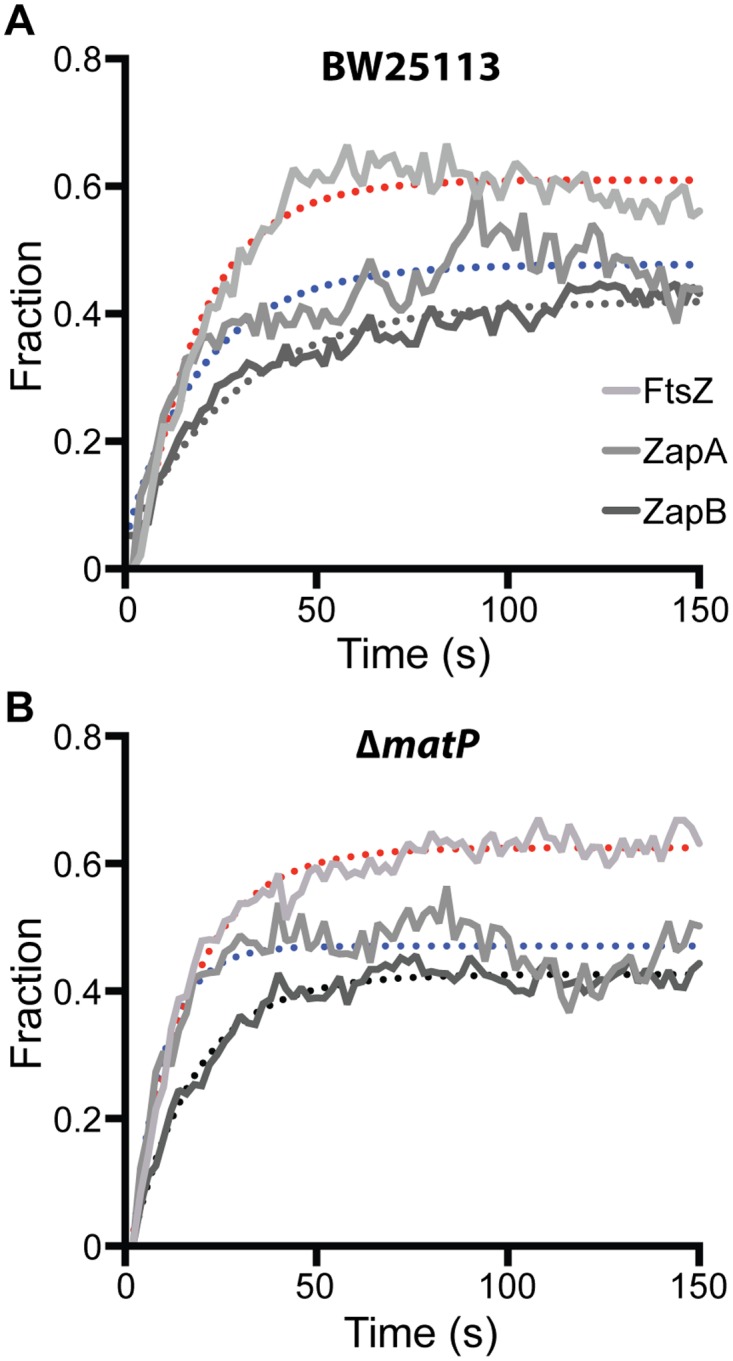
FRAP measurements of FtsZ, ZapA and ZapB turnover rates in BW25113 and ΔmatP cells.Average fluorescence recovery trajectories for FtsZ (light grey), ZapA (grey) and ZapB (dark grey) are displayed for wt (A) and ΔmatP (B) cells as a fraction of pre-bleached intensity. Trajectories were fit with single exponentials illustrated as dotted lines (FtsZ, red; ZapA, blue; ZapB, black). The respective half-times are listed in Table 2.